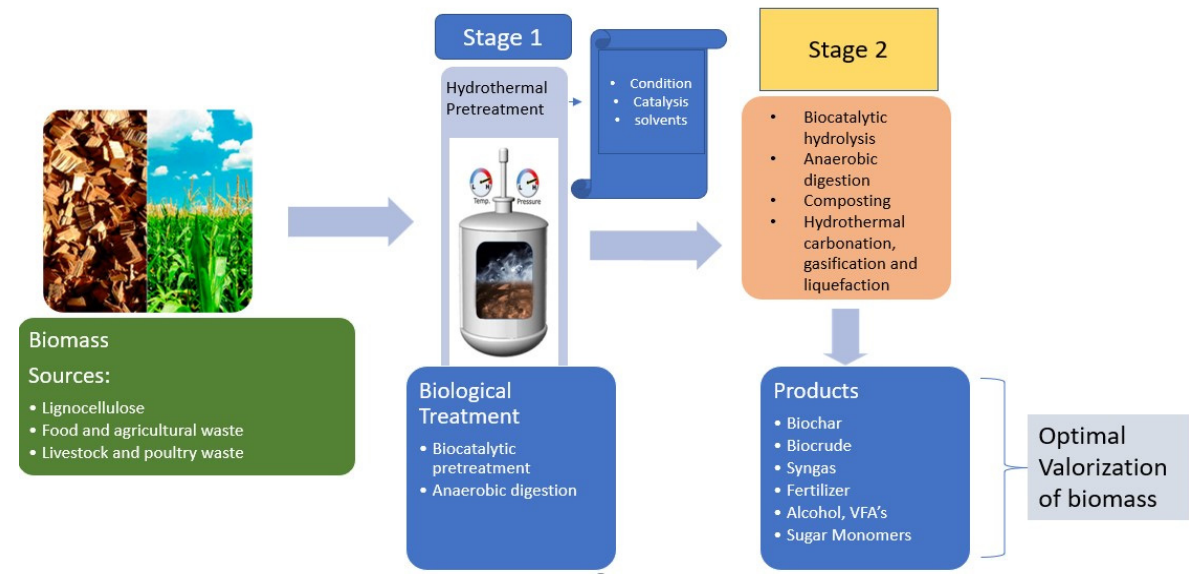
Figure 2. Pictorial representation of the flow-through process entailing the valorization of biomass by hydrothermal and biological means.